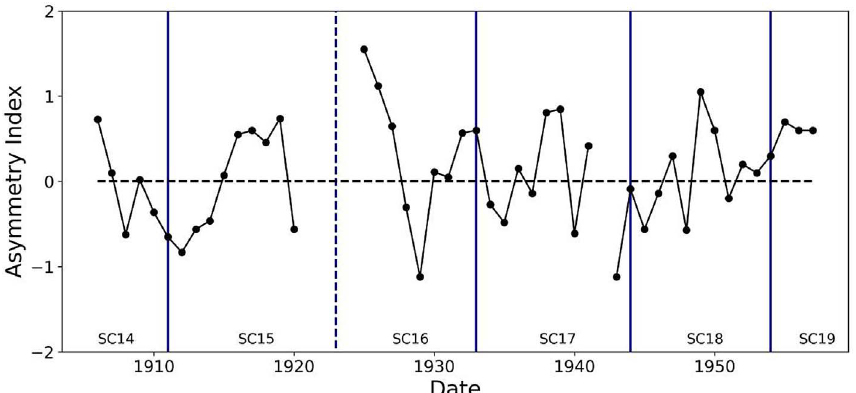
Figure 5. Annual asymmetry index calculated from hemispheric prominence observations carried out at the Madrid Astronomical Observatory from 1906 to 1957. Dashed horizontal line represents a value of the index equal to zero. Vertical solid lines depict the minima of solar cycle according to the Madrid prominence series and the vertical dashed line is the minima of Solar Cycle 16 according to the sunspot number index. Solar cycle numbers are indicated above